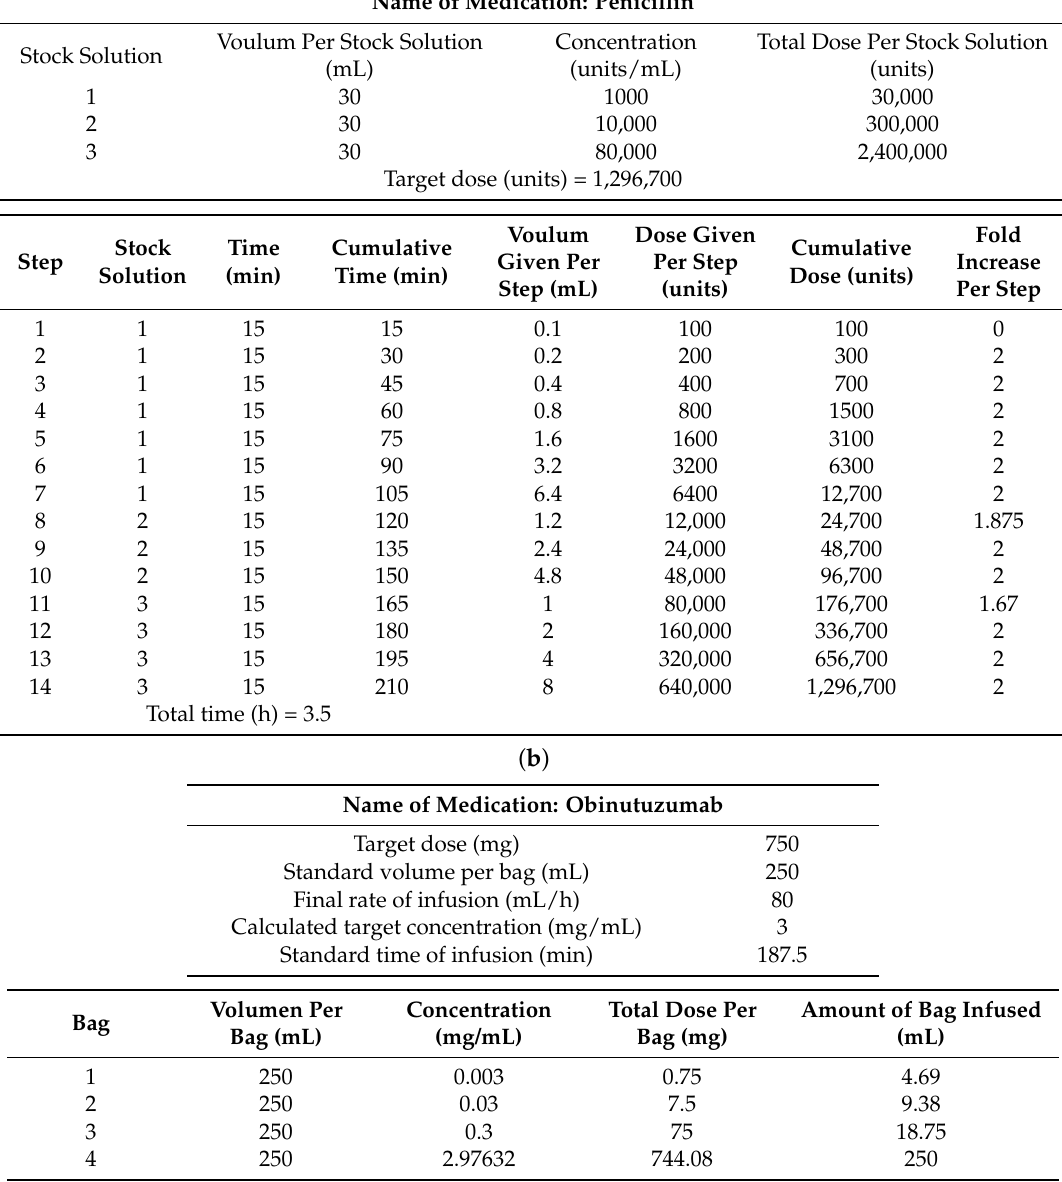
Table 1. ( a ) Example of oral Penicillin Desensitization Protocol. (adapted from Wendel, G.D. et al. “Penicillin allergy and desensitization in serious infections during pregnancy.” NEJM 1985 [36]); ( b ) Example of a 4 bags/16 steps Desensitization protocol to Obinutuzumab (humanized anti-CD20 monoclonal antibody). A patient with prior history of severe rituximab hypersensitivity was empirically desensitized to obinutuzumab. During the first desensitization with a 3 bags/12 step protocol the patient presented with a grade 2 reaction and was subsequently switched to a 4 bags/16 step protocol, without further reactions. Bag 1 was a 1000-fold dilution; Bag 2 was a 100-fold dilution; Bag 3 was a 10-fold dilution; and Bag 4 was calculated to infuse the full target dose at the end of the DS (Desensitization)